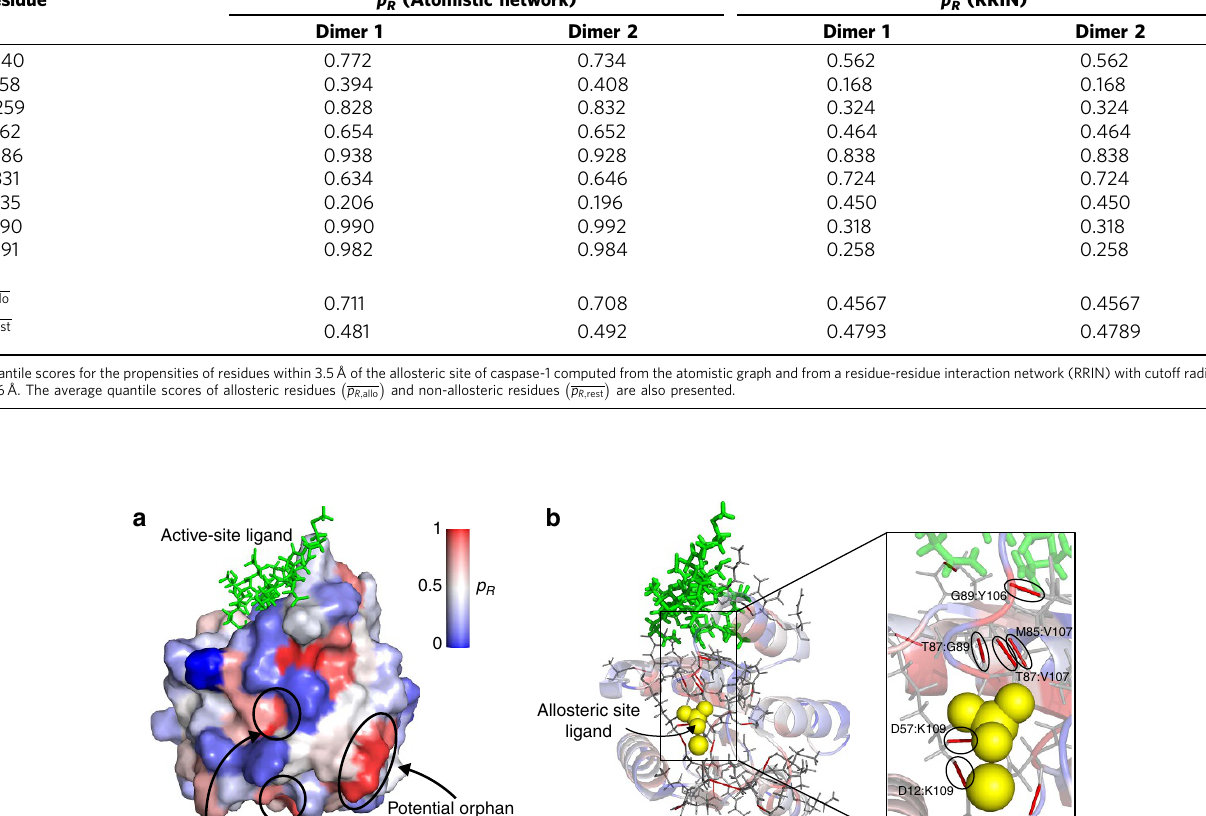
Table 1 | Residue quantile scores of allosteric residues in caspase-1. Residue